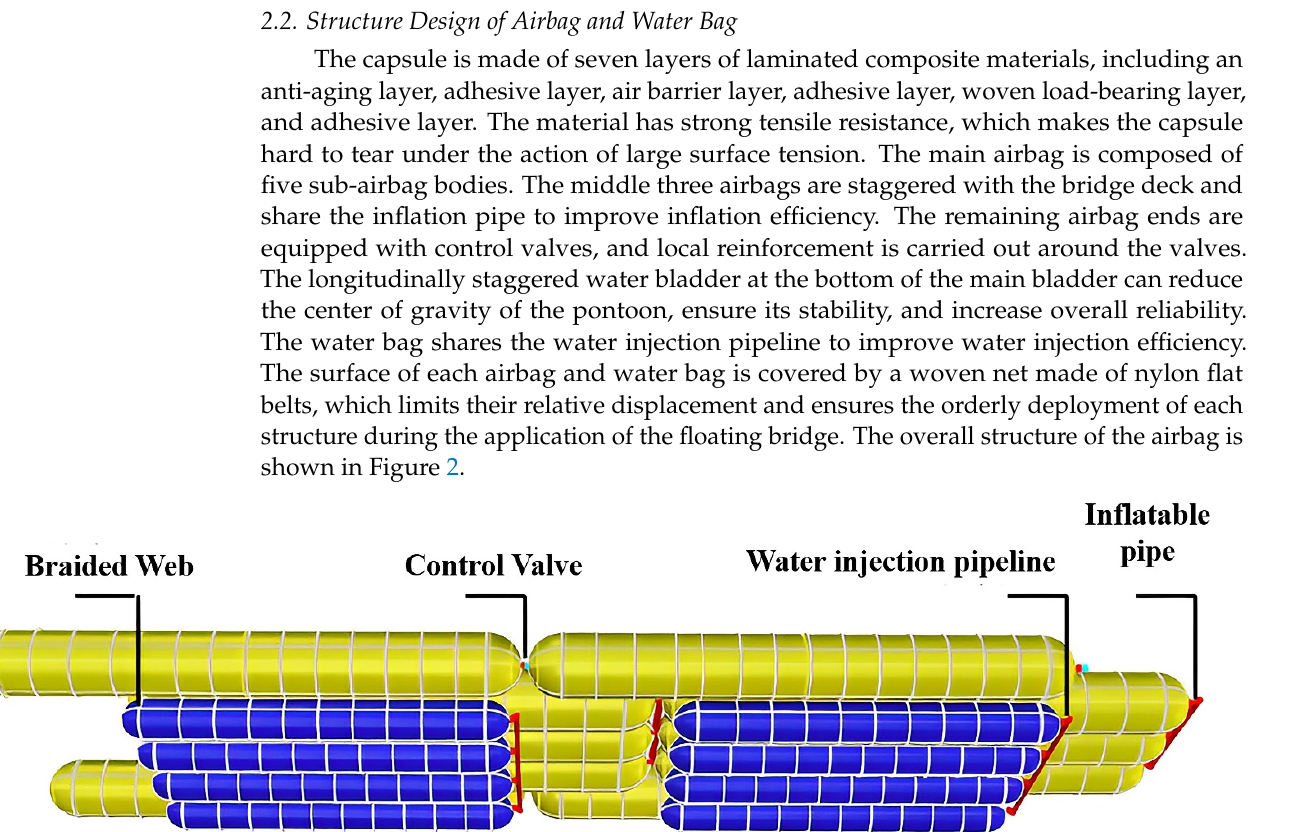
Figure 1. The overall structural design of the rigid-flexible folding floating bridge.